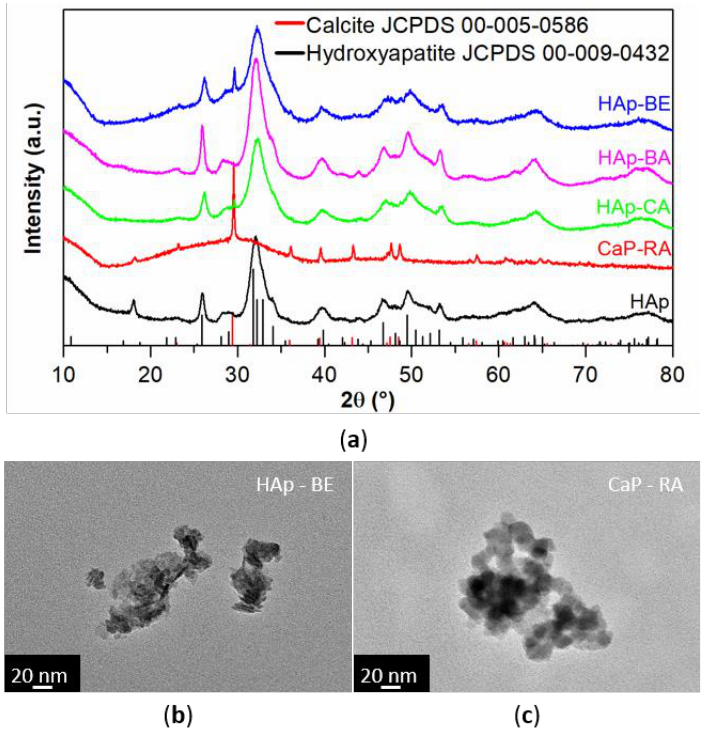
Figure 6. Hydroxyapatite particles synthesized in presence of 0.5 mM polyphenols. ( a ) Superimposition of X-ray diffractogram of HAp NPs, CaP-RA, HAp-CA, HAp-BA, and HAp-BE compared to patterns of hydroxyapatite (JCPDS 09-0432) and calcite (JCPDS 0.5-0586); TEM images of ( b ) HAp-BE; ( c ) CaP-RA.